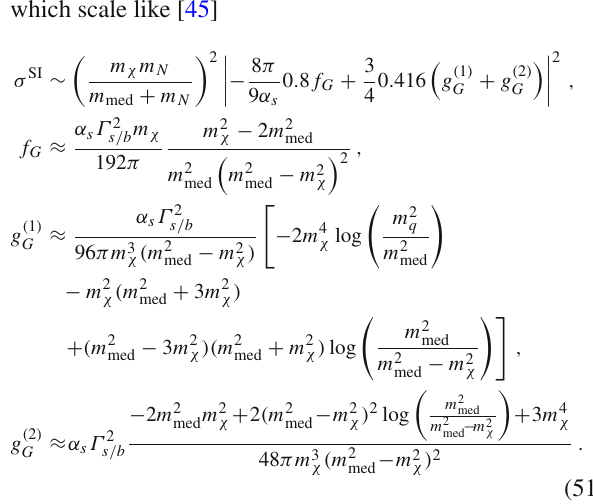
tions receive additional contributions from these diagrams, which scale like